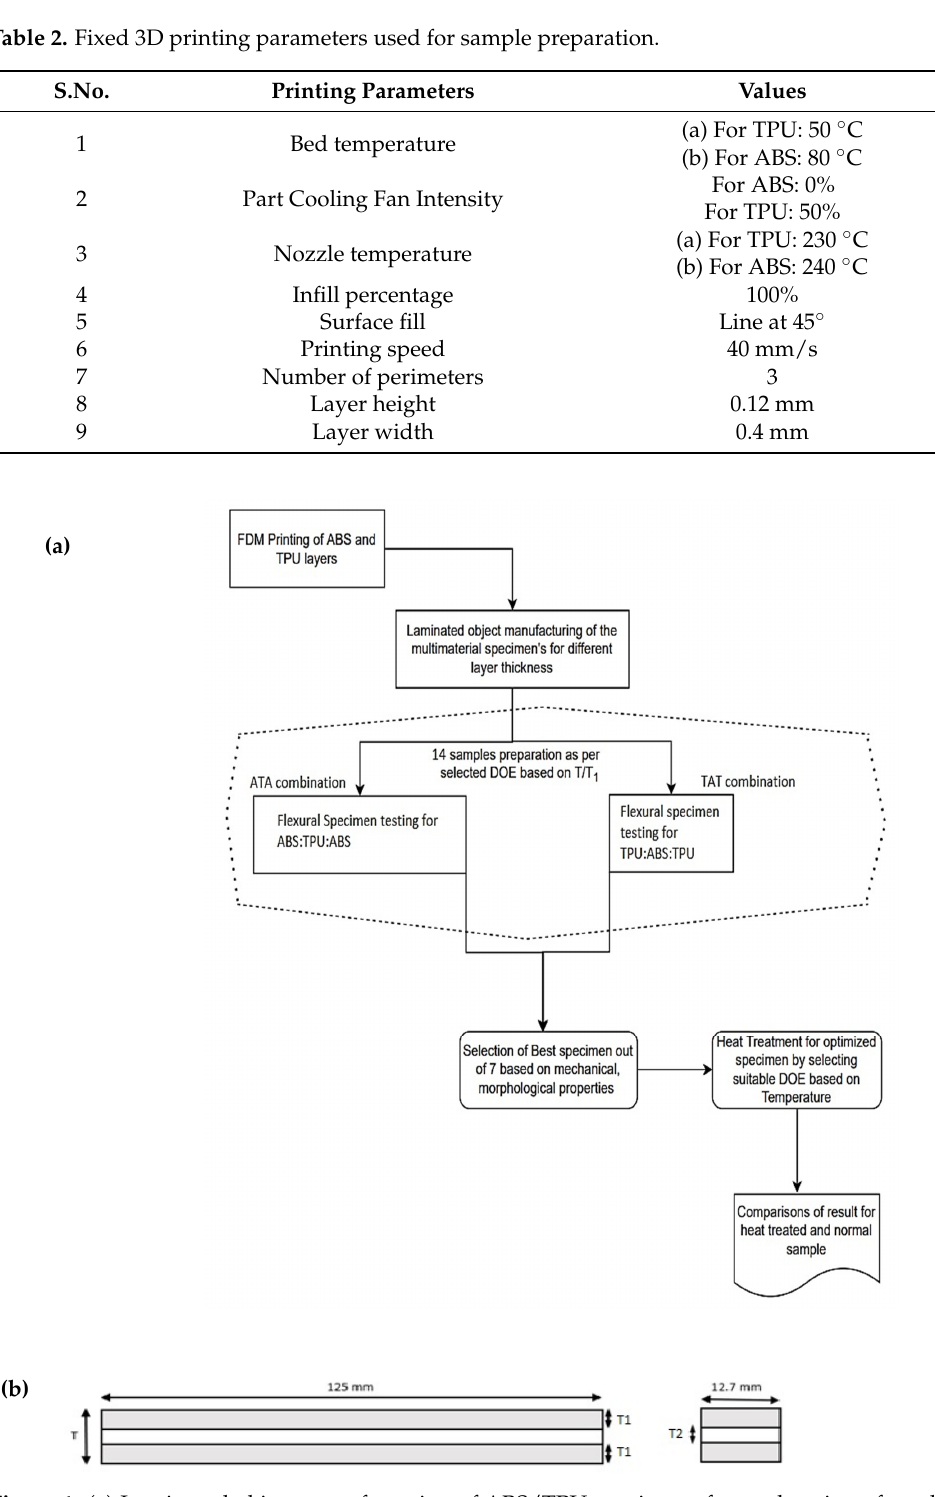
Figure 1. ( a ) Laminated object manufacturing of ABS/TPU specimens for exploration of mechanical and morphological properties. ( b ) Schematic view of multi-material bending specimen as per ASTM D790.